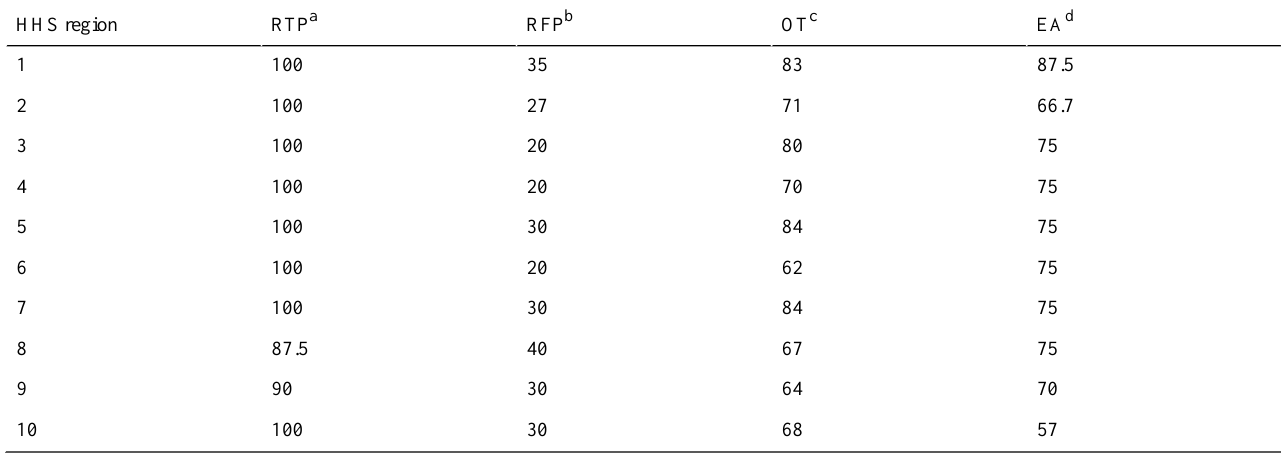
Table 5. Result of Poisson cumulative sum (threshold = 1 * k) for all performance metrics across all Department of Health and Human Services (HHS) regions of the United States.